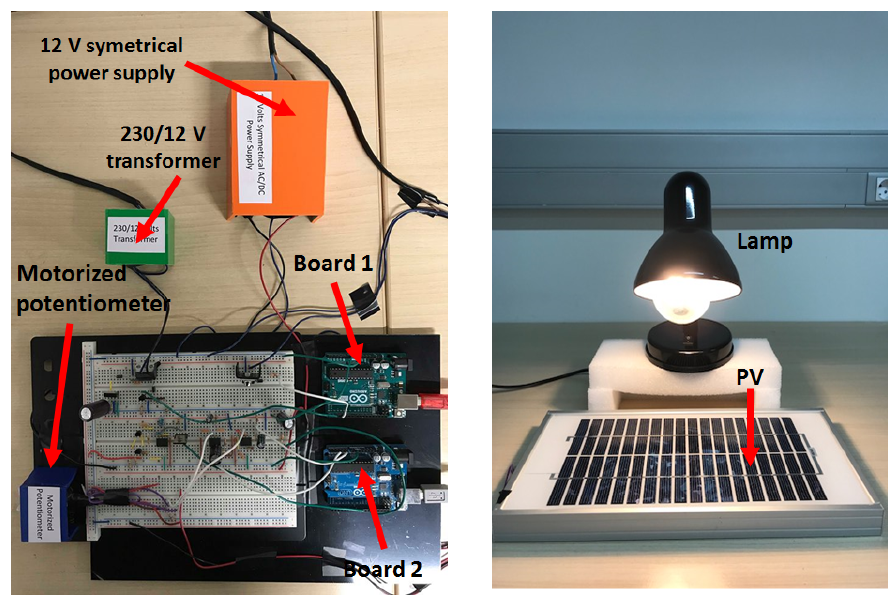
Figure 9. The experimental platform implementation.